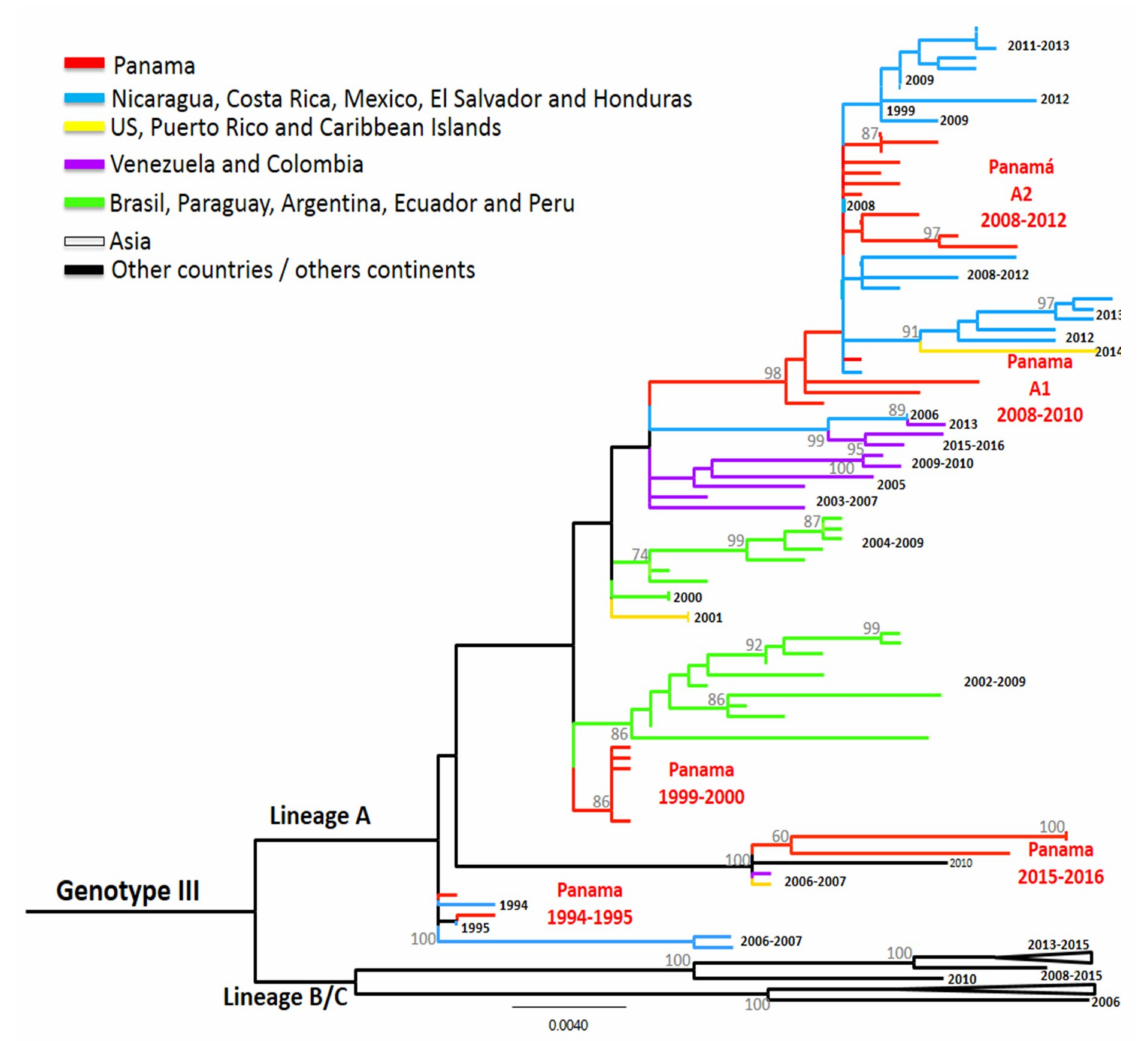
Figure 4. Maximum-likelihood (ML) consensus tree of the Envelope (E) protein gene of DENV-3. The ML tree was constructed using the model General Time Reversible (GTR + I + gamma), showing bootstrap values > 70 (1000 replicates). Green color represents DENV-3 Panamanian strains ( n =